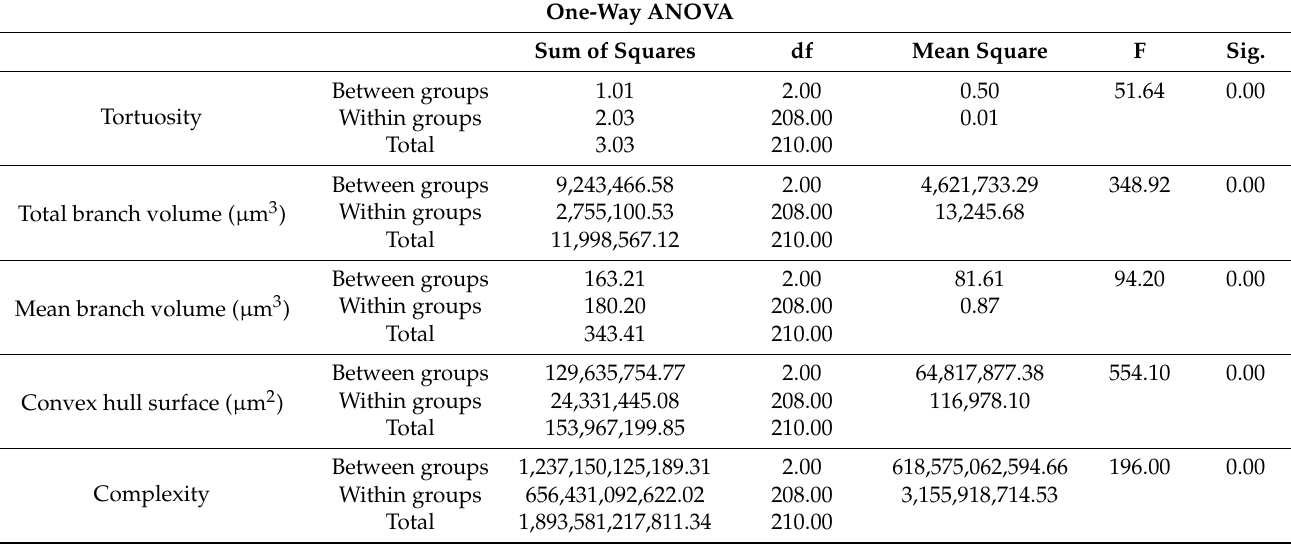
Table 3. Results of the one-way analysis of variance (ANOVA) indicating significance (Sig.) and respective F values from group